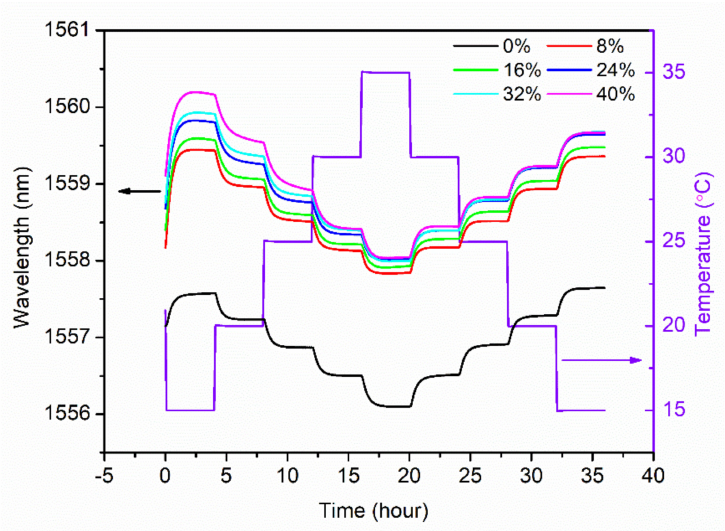
Figure 4. Evolutions of Bragg wavelength in terms of temperature between 15 ◦ C and 35 ◦ C with a step of 5 ◦ C (increase and decrease). This experiment was conducted for a series of soils with different SMCs (0%, 8%, 16%, 24%, 32% and